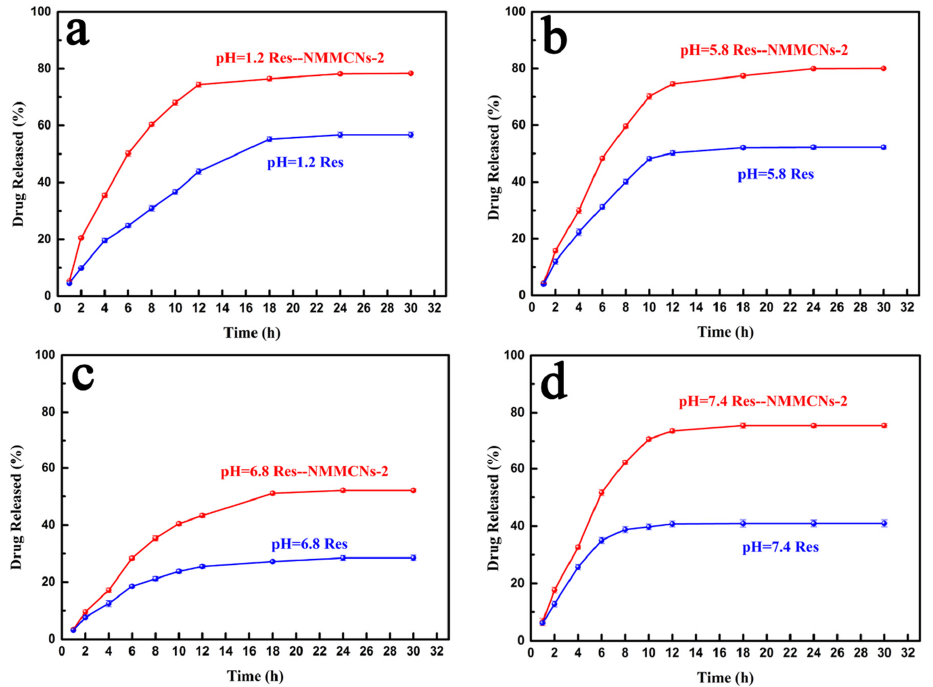
Figure 12. The drug release curves of pure Res and Res–NMMCNs-2 at different pH values (( a ), pH = 1.2; ( b ), pH = 5.8; ( c ), pH = 6.8; ( d ), pH = 7.4).